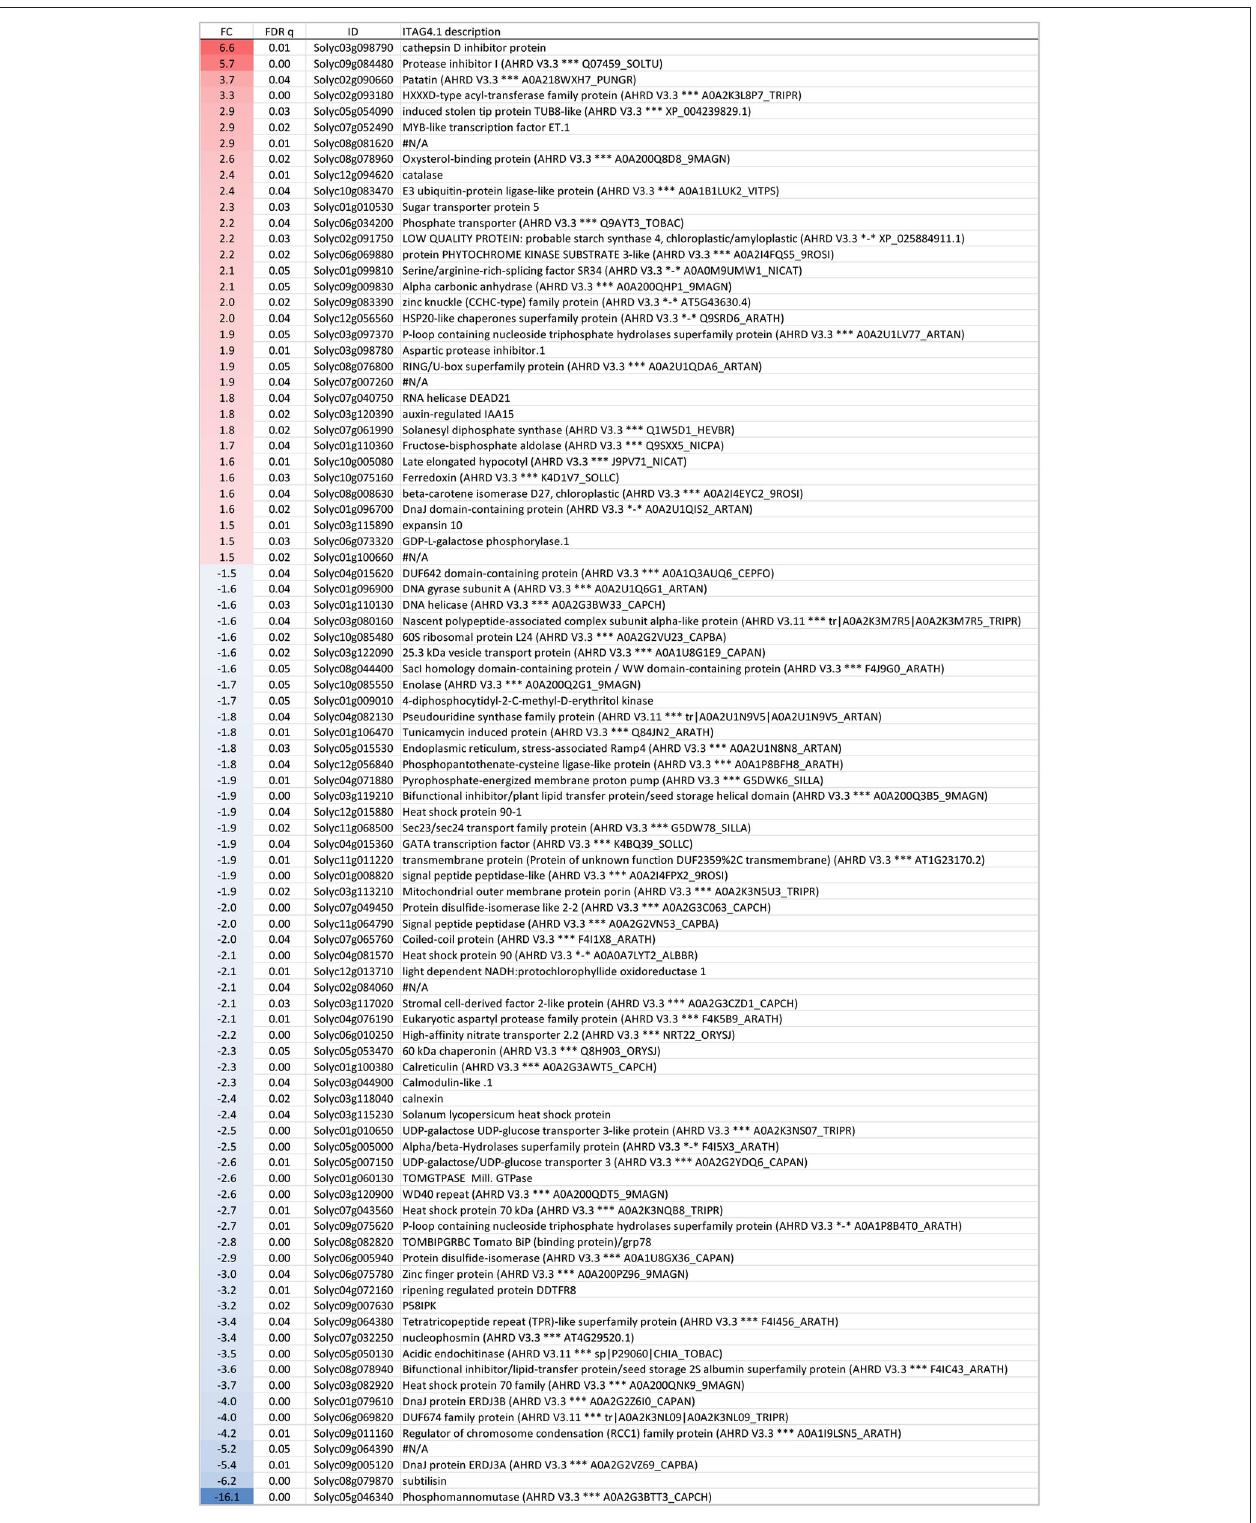
FIGURE 6 | Genes expressed significantly differently (FDR ≤ 0.05 and |fold change| > 1.5) between 4-day long-term mild heat (LTMH) and control temperature (CT) treatments. The first, second, third, and fourth columns are fold change (FC), FDR q value, Solyc gene code, and functional description, respectively. Positive FC value (red label), expressed higher after LTMH than CT; negative FC value (blue label), expressed lower after LTMH than CT.